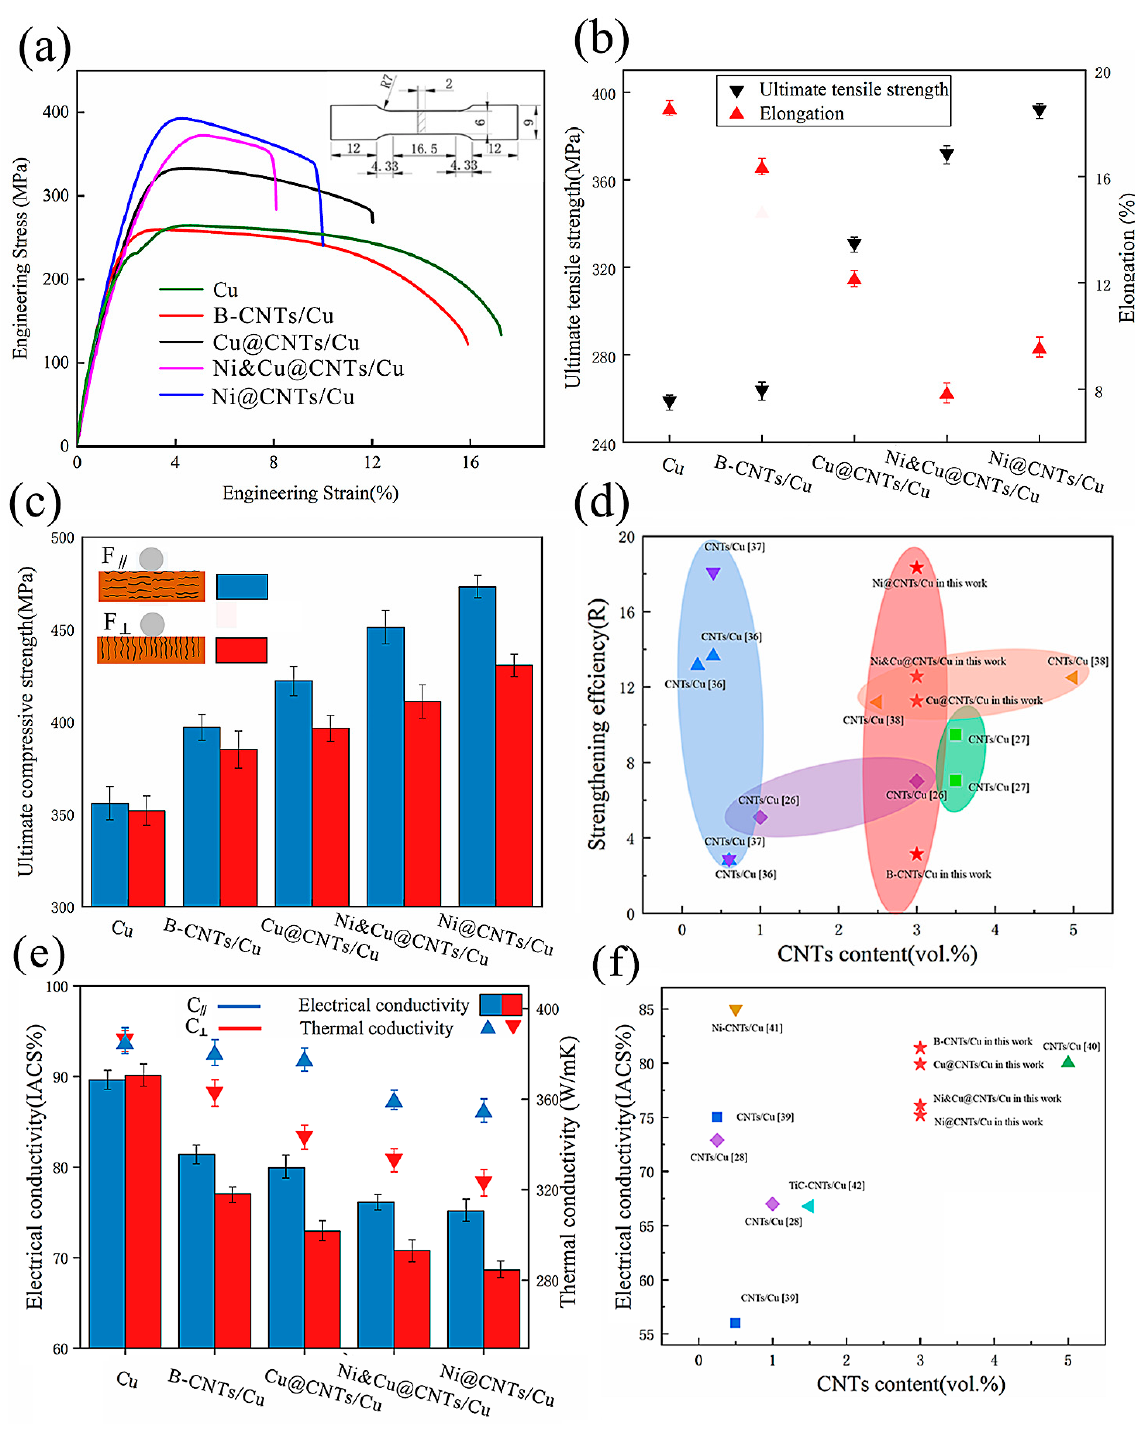
Figure 1. ( a ) Stress–strain curves, ( b ) ultimate tensile strength and elongation, ( c ) compressive strength of samples. ( d ) R-value of CNTs in this work compared with data in the literature [11,26,36–38]. ( e ) Electrical conductivity and thermal conductivity of samples. F ∥ , C ∥ test plane parallel to the drawing direction, F ⊥ , C ⊥ test plane perpendicular to the drawing direction. ( f ) Electrical conductivity of samples compared with the published data [28,39–42].